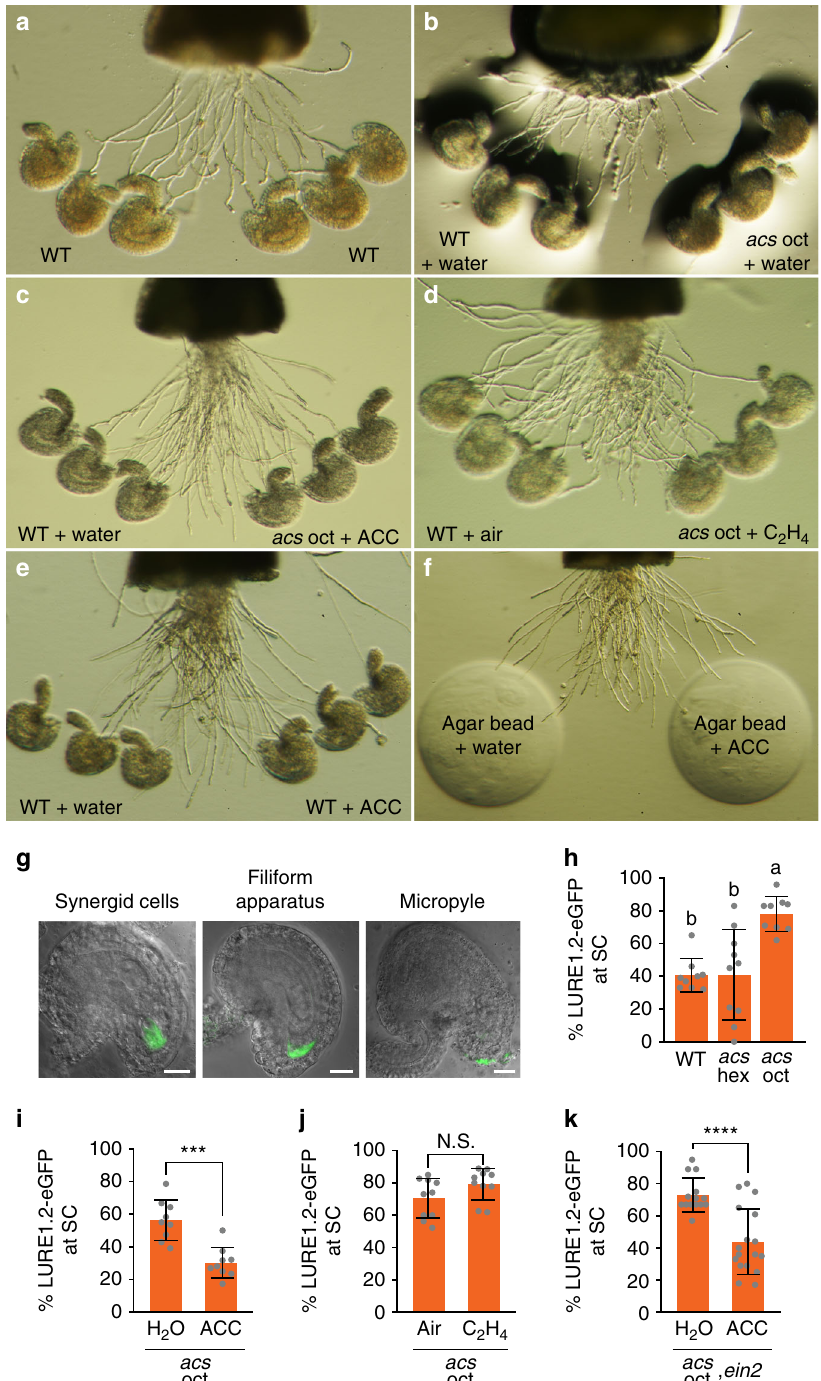
Fig. 2 ACC has an ethylene-independent role in pollen tube attraction and LURE1.2-eGFP localization. a – f Representative images of semi-in vivo pollen tube guidance assays. Pretreatments ( + water, + ACC, + C 2 H 4 ) of ovules and agar beads are indicated. g Representative images of LURE1.2-eGFP localization in acs oct ovules 24 h after emasculation of stage 12c fl oral buds. Scale bar, 20 μ m. h-k Average percentages of synergid cell